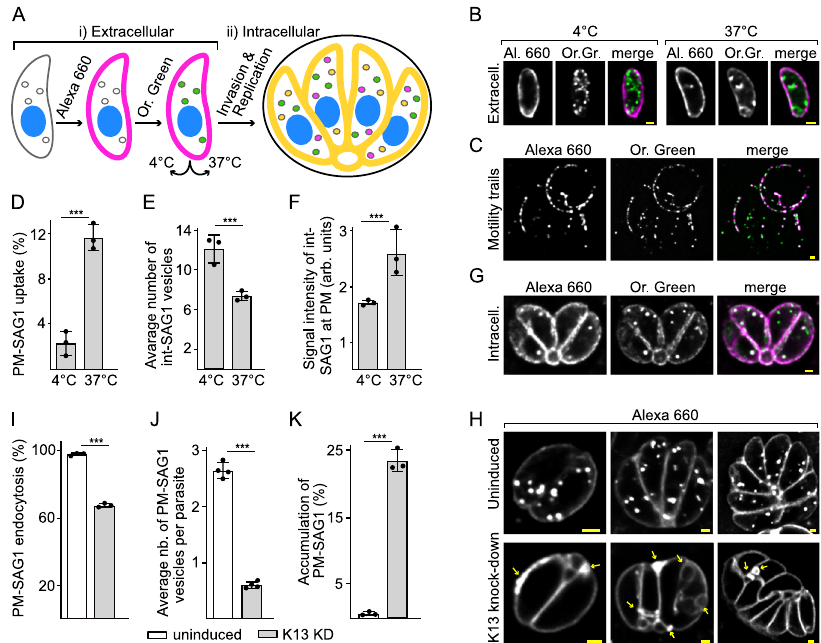
Fig. 5 | SAG1-Halo-bound ligands report on endocytosis which is reduced in K13-depleted parasites. A Schematic of differential labelling of SAG1 pools at the plasma membrane surface (PM-SAG1 stained with Alexa 660, magenta) or in internal vesicles (Int-SAG1 stained with Oregon Green, green) and tests for endo- cytic recycling at either non-permissive (4°C) or permissive (37°C) temperatures (i).Infection of hosts after labellingallows these processesto be monitored during intracellulargrowth(ii)(orangeindicatesco-locationofsignals). B Liganddetection of labelled extracellular cells incubated at either 4°C or 37°C. C Motility trails of labelled SAG1 left by gliding parasites at 37°C. Differences according to tempera- turetreatmentin: D thepercentageofcellswithinternalizedPM-SAG1asameasure of endocytosis ( P value = 3.52E − 5), E the number of Int-SAG1 vesicles per cell as a measure of exocytosis ( P value = 3.03E − 16), and F the intensity of Int-SAG1 at the cellsurfaceasafurthermeasureofexocytosis( P value=9.82E − 6). G Redistribution